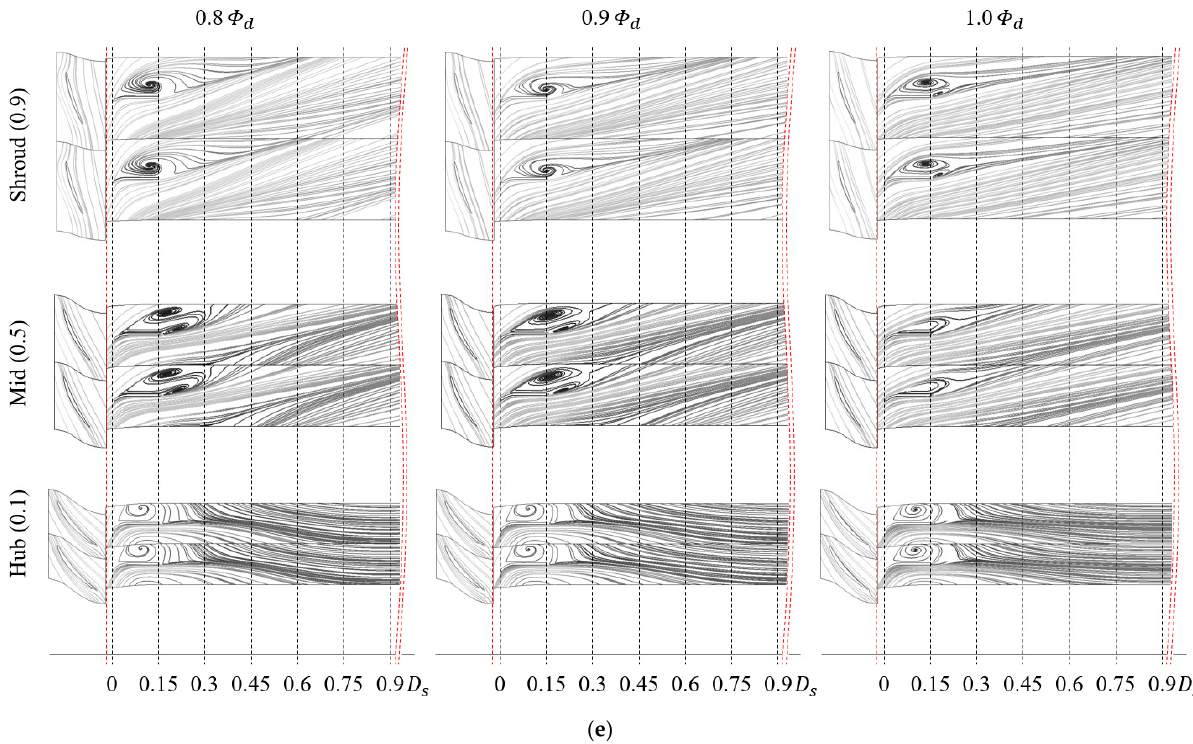
Figure 13. Internal flow fields with limiting streamlines in blade-to-blade view: ( a ) none; ( b ) 2D-10; ( c ) 2D-70; ( d ) 3D-10; ( e ) 3D-70.